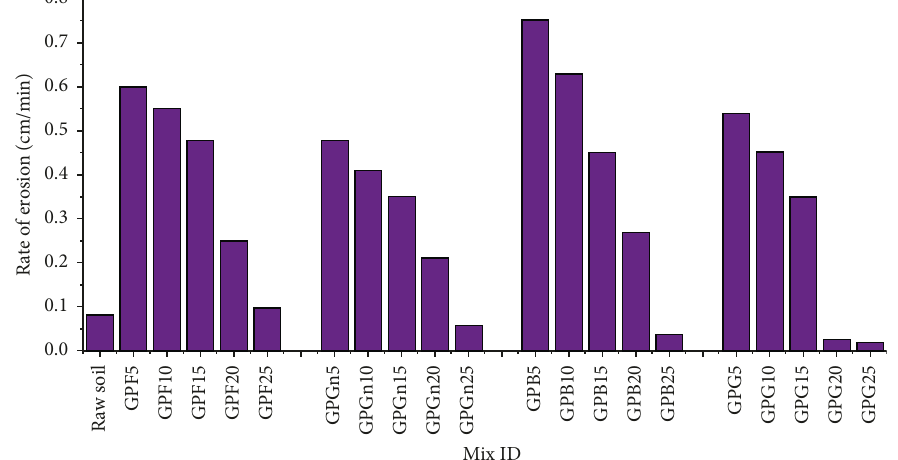
Figure 7: Spray erosion of stabilized geopolymer mud